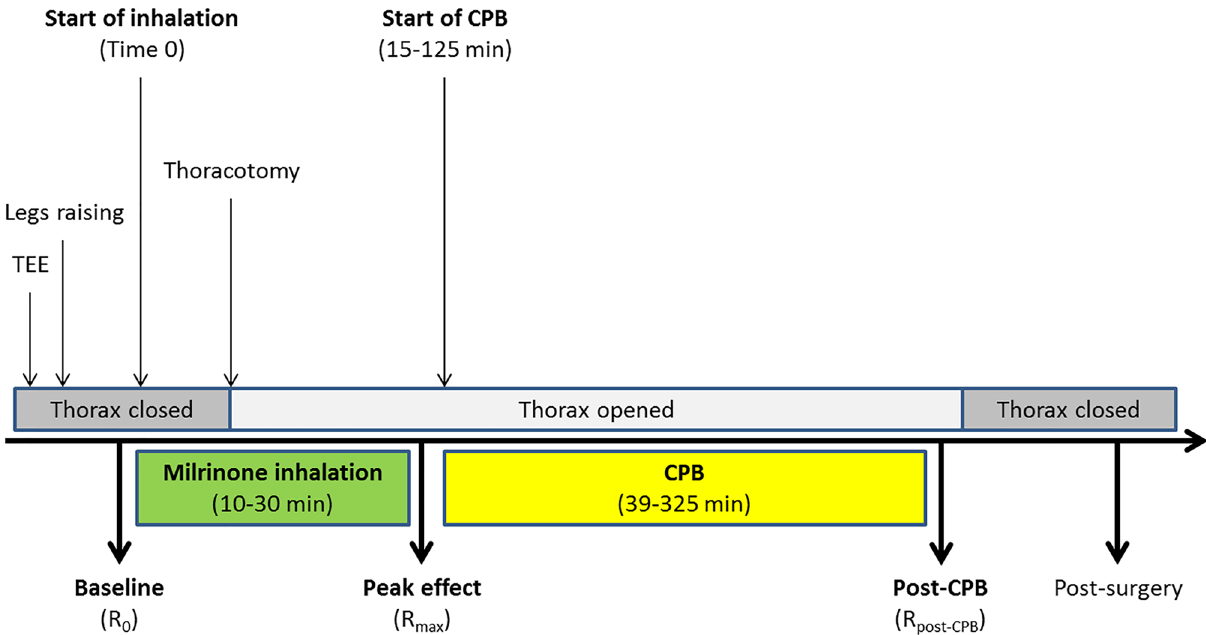
Figure 1. Important events and cut-off times used for data analysis on a typical cardiac surgical procedure time flow chart. CPB cardiopulmonary bypass, R 0 baseline mAP/mPAP ratio, R max peak mAP/mPAP ratio, R post-CPB post-CPB mAP/mPAP ratio, TEE transesophageal echocardiographic